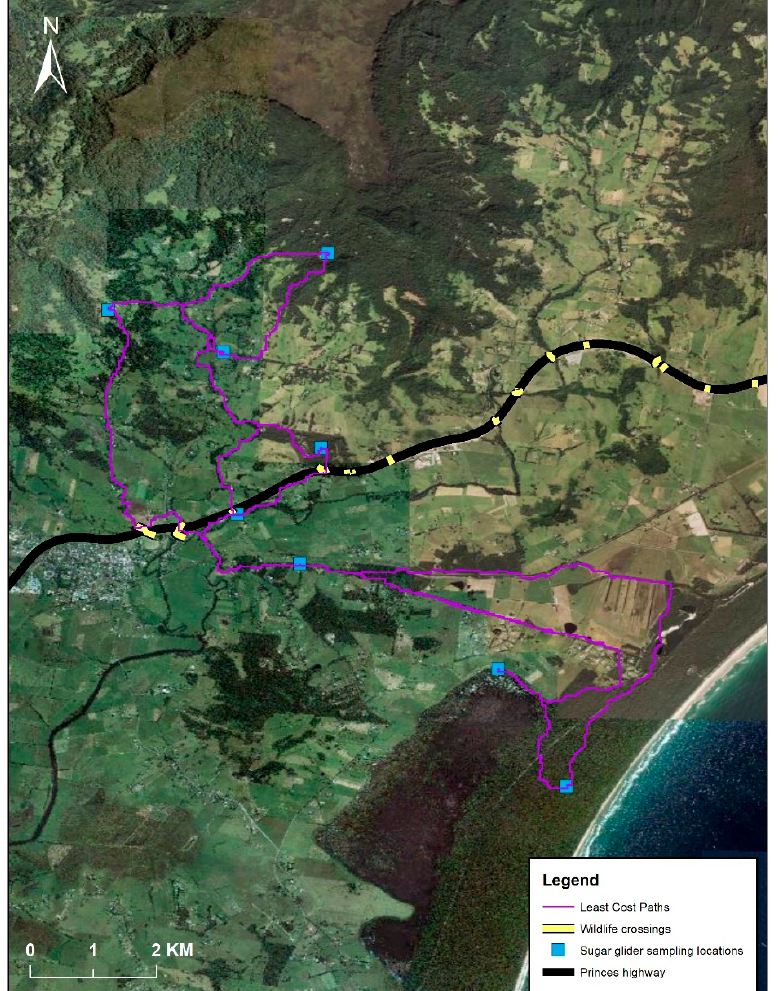
Figure 5. Least-cost paths tested among eight sampling locations within the Berry Wildlife Corridor area.